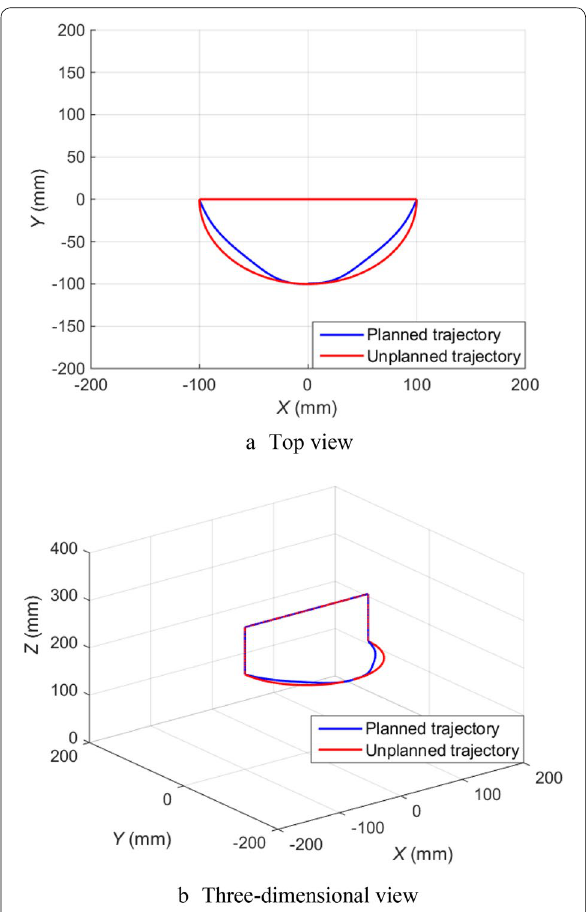
Figure 16 Planned and unplanned trajectories for double-S velocity curve